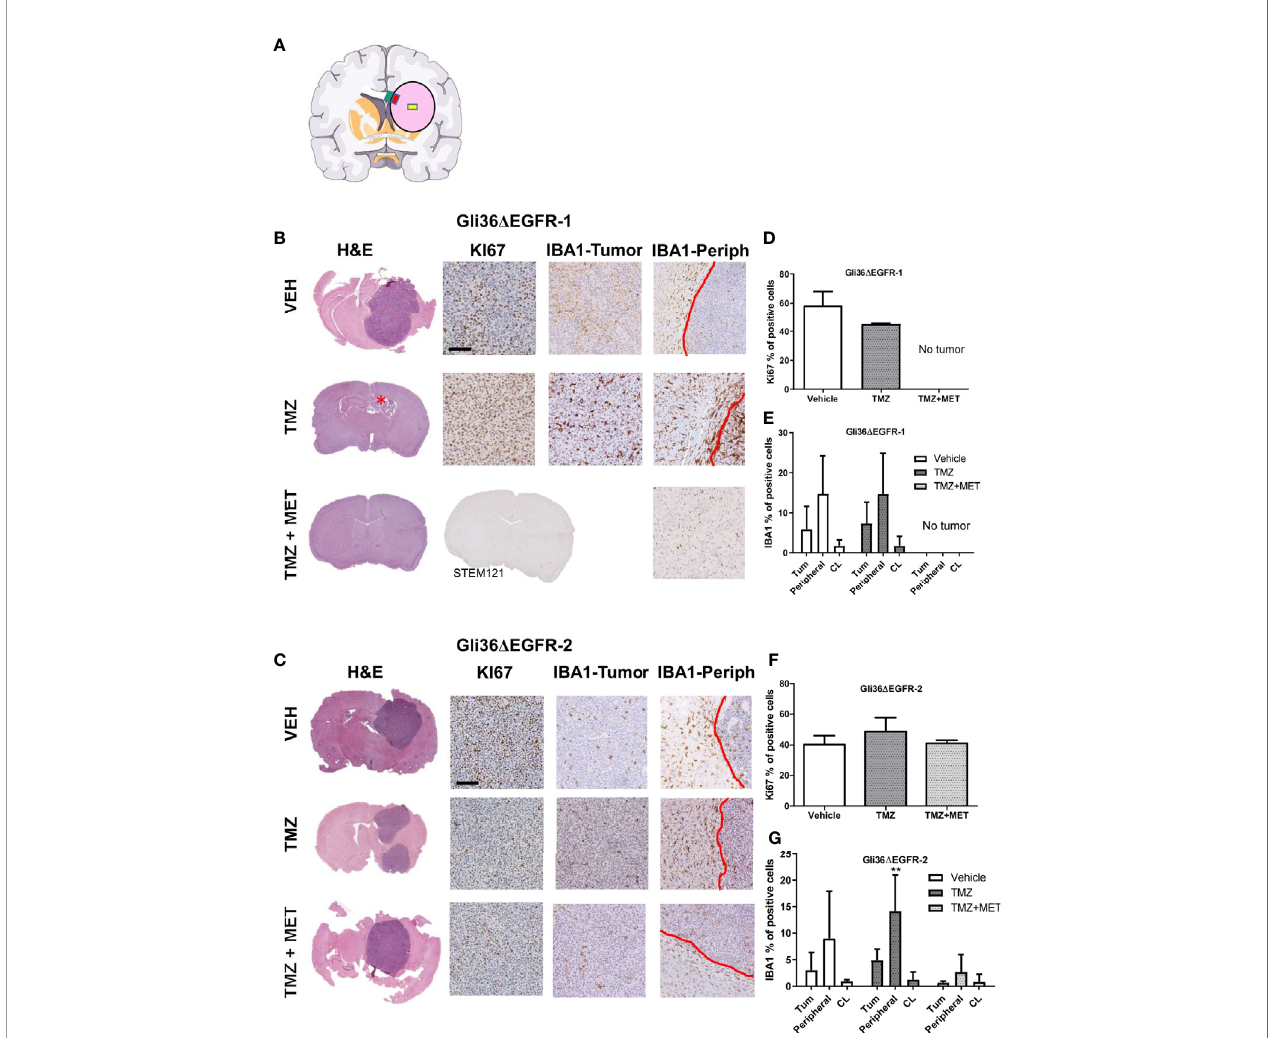
FIGURE 3 | Evaluation of KI67 and IBA1 in GBM mouse samples at the end of survival study. (A) , schematic representation of the brain areas sampled for Iba1 quanti fi cation. The pink circle indicates the tumors, the yellow square indicates the Regions of Interest (ROI) placed on the tumor, the red one that placed on the inner border, and the green one that placed on the outer border. (B, C) , images of representative hematoxylin and eosin (H&E), Ki67 and Iba1 staining for intracranial Gli36 D EGFR-1 and Gli36 D EGFR-2 tumors from mice treated with vehicle (VEH, n=5 for R1, n=3 for R2), TMZ (n=2 for R1, n=4 for R2) and TMZ+MET (n=5 for R1 and n=3 for R2) euthanized at the end of survival study. Gli36 D EGFR-1 TMZ+MET tumors were stained also with STEM121. (D, F) , quanti fi cation of the ki67 marker expressed as the percentage of positive cells. One-way ANOVA analysis followed by Tukey ’ s multiple comparison test. (E, G) , quanti fi cation of IBA1 marker expressed as percentage of positive cells in the inner part of the tumor (Tum), in tumor-brain border (Peripheral) and in the brain region contralateral to the tumor (CL). Two-way ANOVA analysis followed by Bonferroni ’ s multiple comparison test, **p = 0.0050 TMZ+MET vs